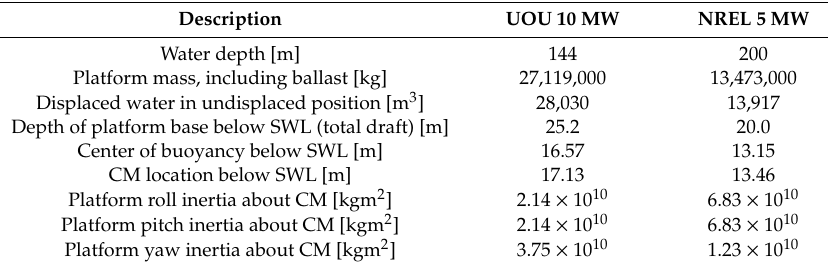
Table 2. UOU 10-MW Platform Specifications.